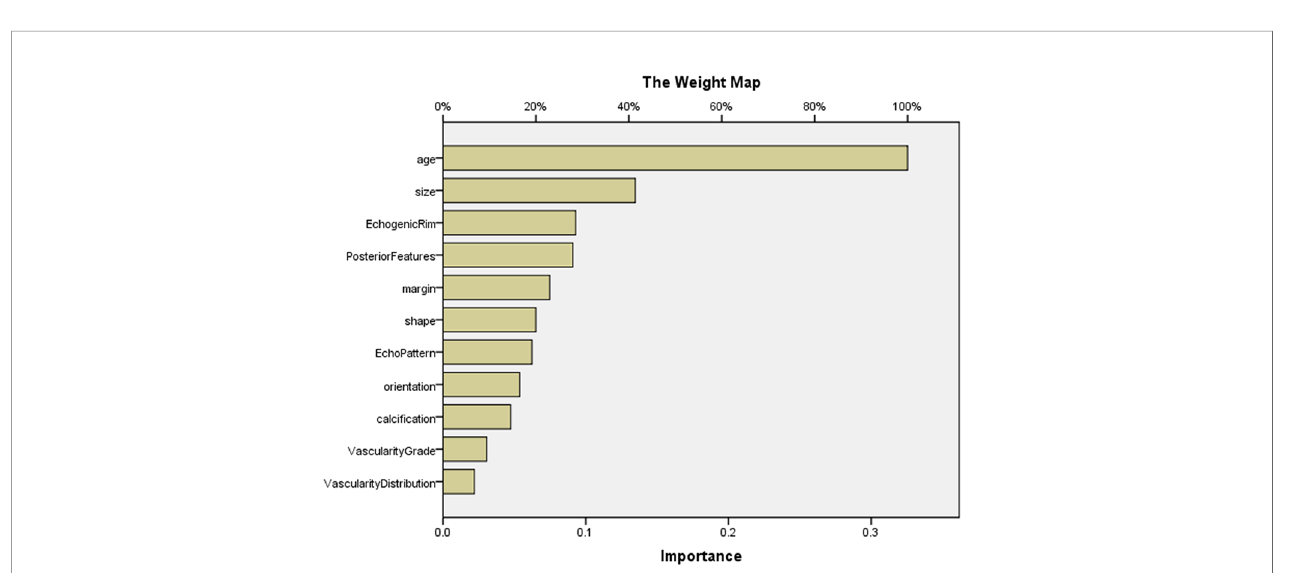
FIGURE 2 | The importance of features in MLP for predicting MBC and FA. The map could present the importance of each feature. The longer the bar represented by this feature, the greater its weight. According to the map, the top 5 features were age, size, echogenic rim, posterior features, and margin. MLP, multilayer